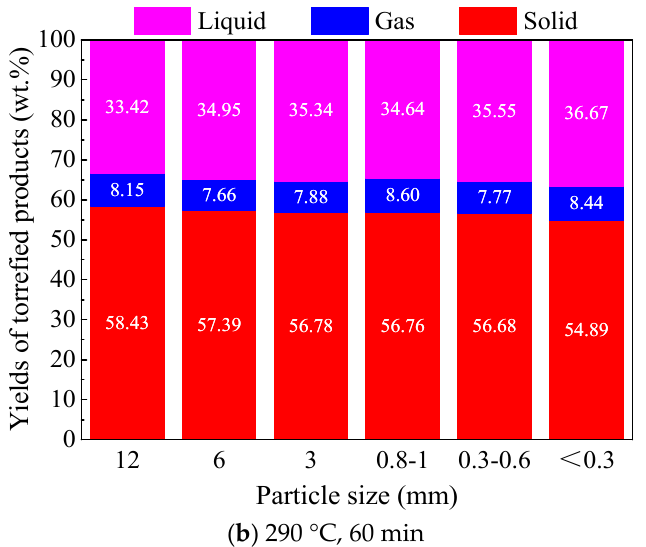
Figure 2. Effect of particle size on the product distribution of Paulownia wood torrefaction under different temperatures.